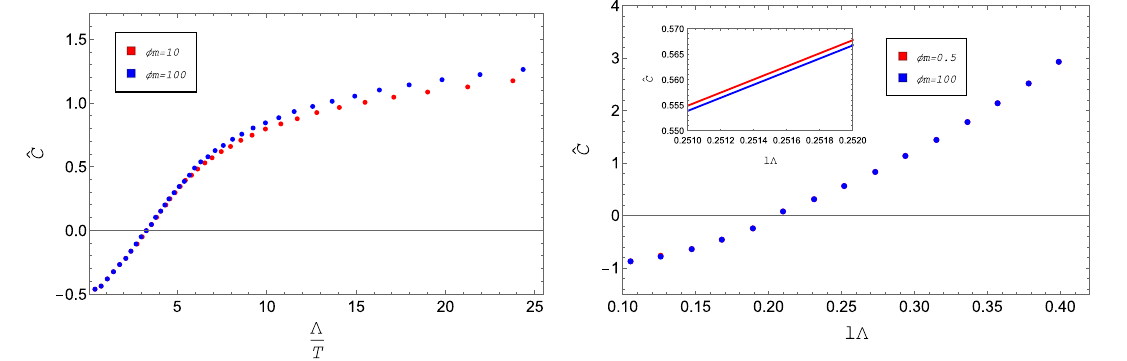
Fig. 4 Left: The relative subregion complexity ˆ C = C ( T ) − C AdS ( T = 0 . 8 ) C as a function of (cid:3) for fixed (cid:3) = 0 . 8 and l = 0 . 21. Different curves T correspond to distinct φ M = 10 (red) and φ M = 100 (blue). Right: The